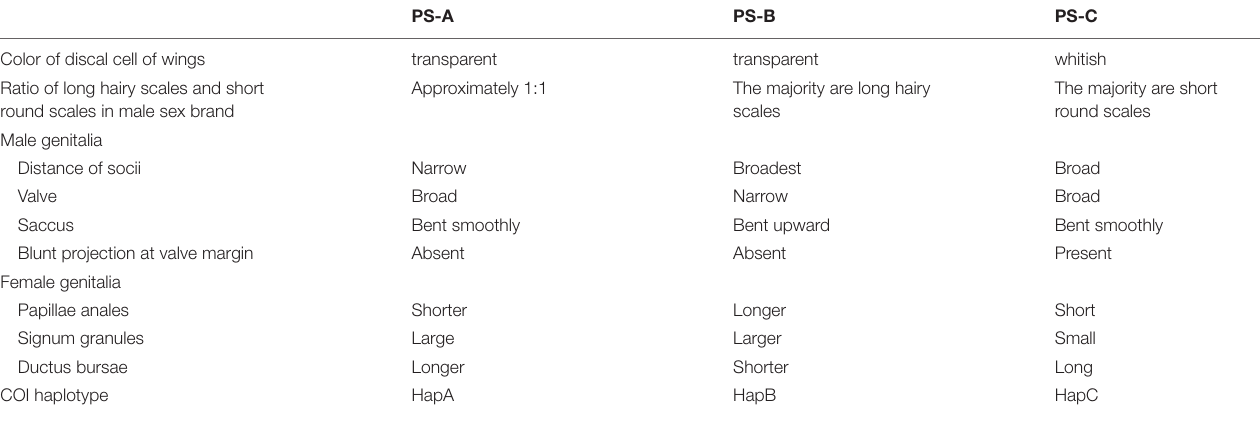
TABLE 3 | Summary of the distinguishing characters for the Parantica sita lineages: PS-A, PS-B, and